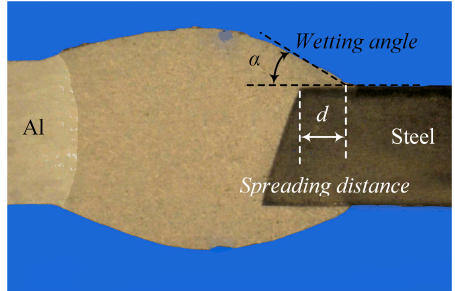
Figure 2. Definitions of spreading distance and wetting angle.